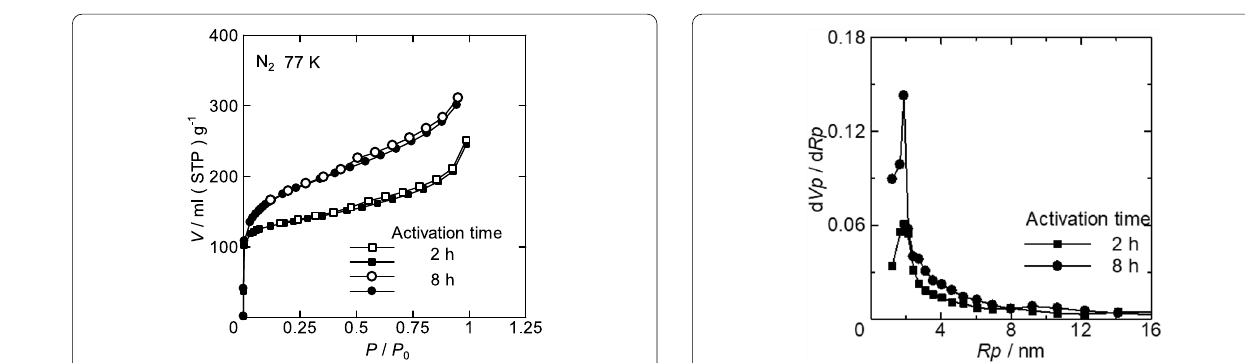
Table 1 Pore characteristics of activated tunicate cellulose (TC) carbons prepared by impregnation with a 20% H for various times